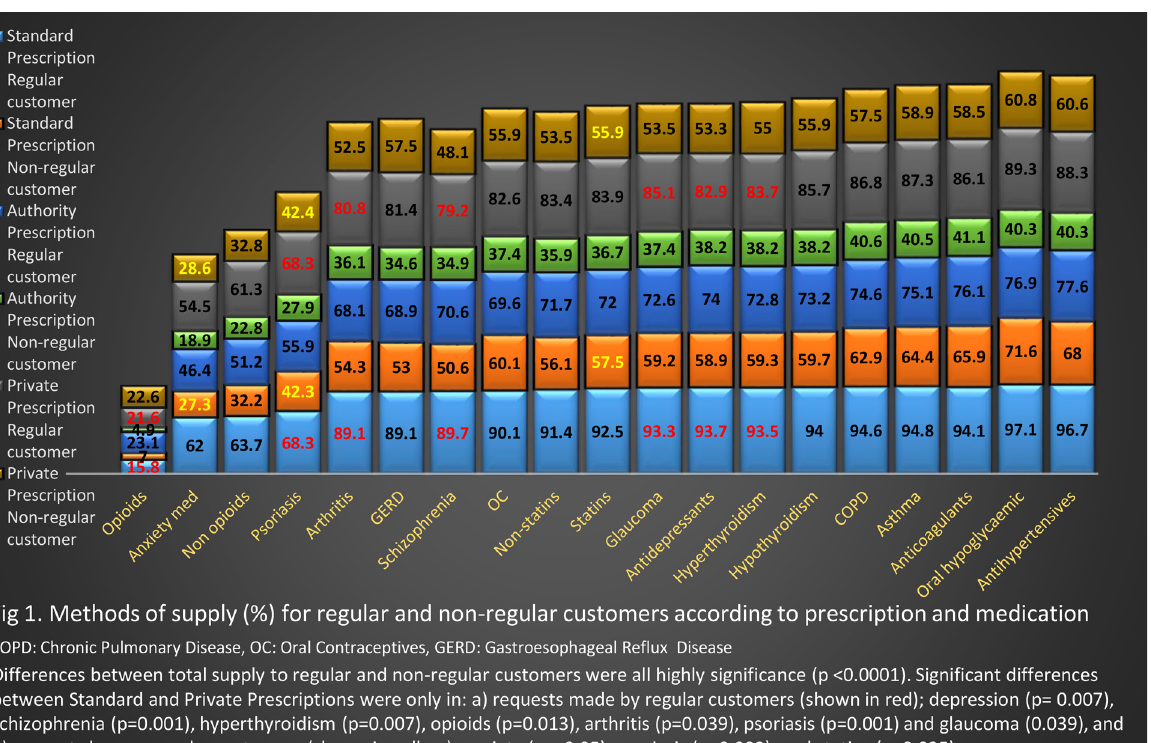
PLOS ONE | DOI:10.1371/journal.pone.0154992 May 12,